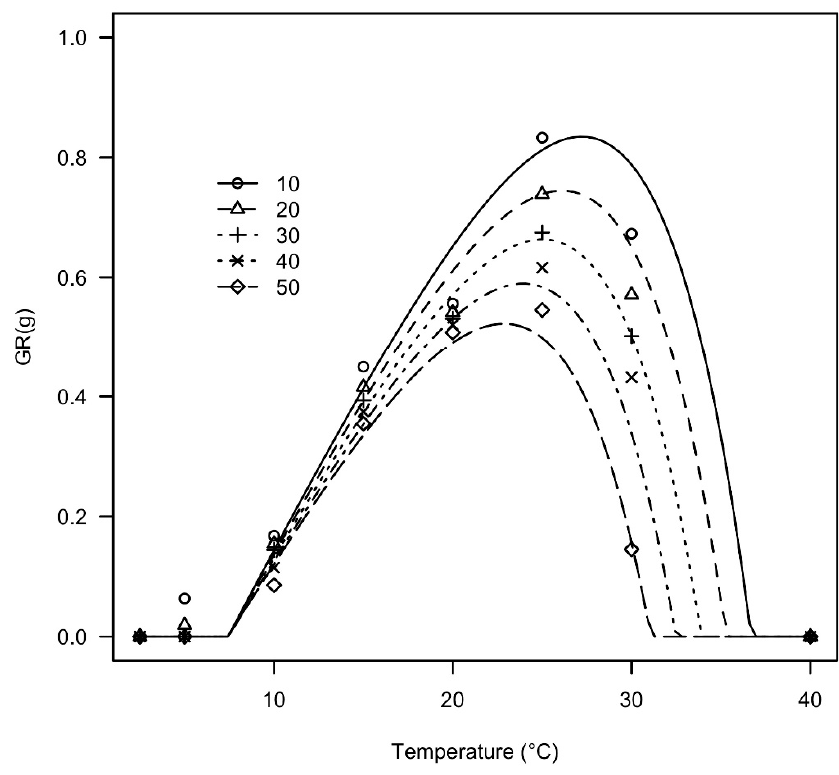
Figure 3. Relationship between germination rates for different percentiles ( g ) and temperatures. Symbols show the observed data, while lines show the fitted curves (Equation (3), with the parameters in Table 4). Table 4. Influence of temperature on the germination rates for Conyza canadensis : parameters quickest seed in the lot, b 1 : slope for Θ T as a function of the percentile, k : shape parameter, T c(0) : ceiling temperature for the quickest seed in the lot, b 2 : slope for T c as a function of the percentile. Parameters